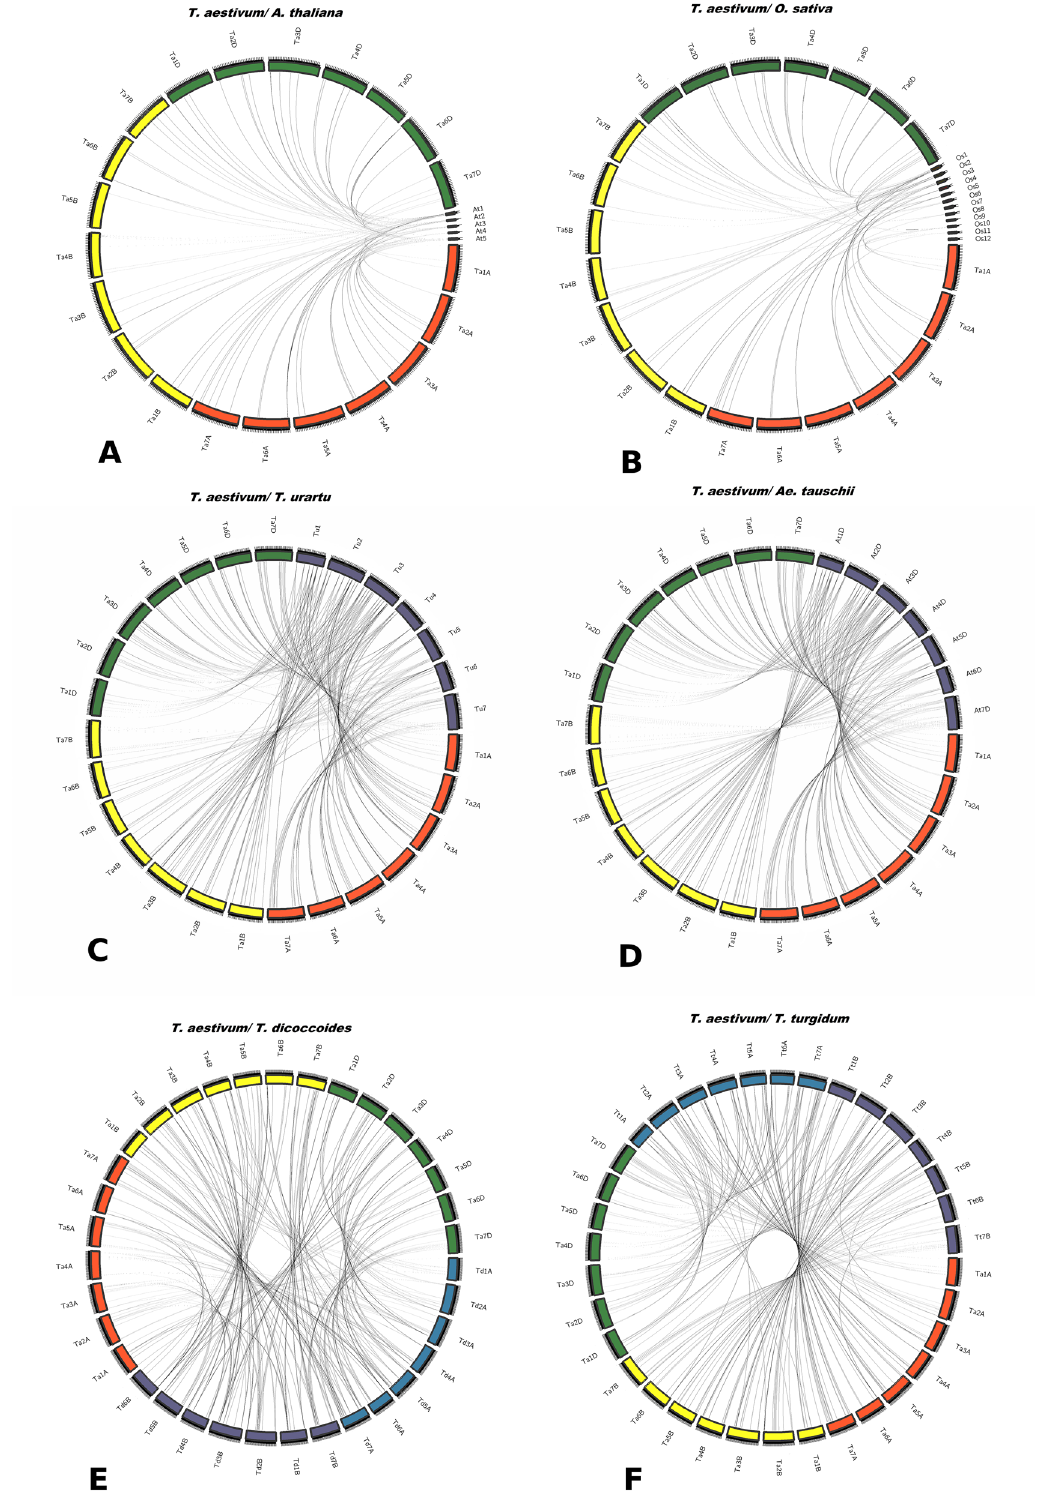
Figure 3. Synteny relationships of wheat nitrate transporter genes orthologous with ( A ) A. thaliana, ( B ) O. sativa, ( C ) T. urartu , ( D ) Ae. tauschii, ( E ) T. dicoccoides and, ( F ) T. turgidum. Circos plots were generated by web-based application- shinyCircos (https:// venyao. xyz/ shiny circos/) 46